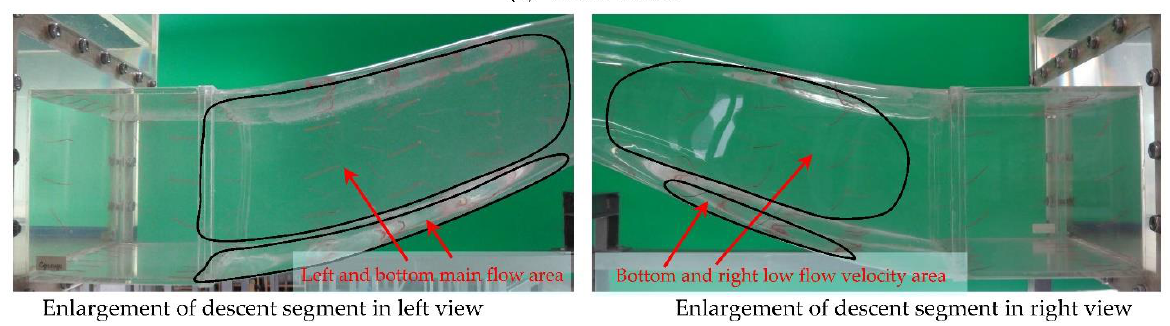
Figure 15. Pictures of flow pattern in outlet conduit under different guide vanes.